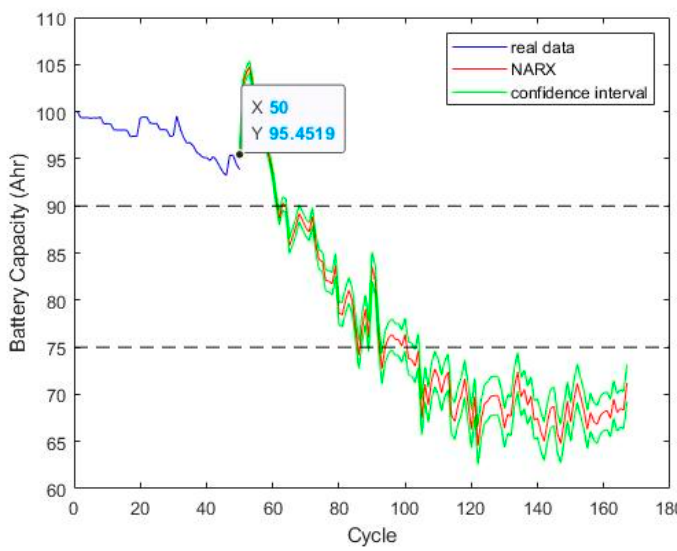
Figure 14. Prediction results of NARX (after 50 cycles).